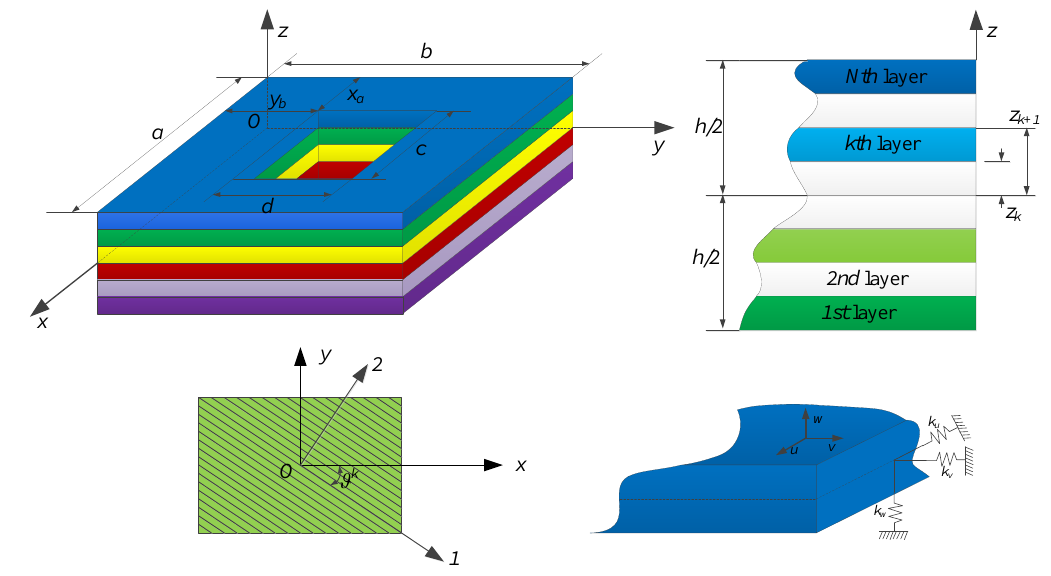
Figure 1. Model of laminated composite rectangular plate with a rectangular cutout.